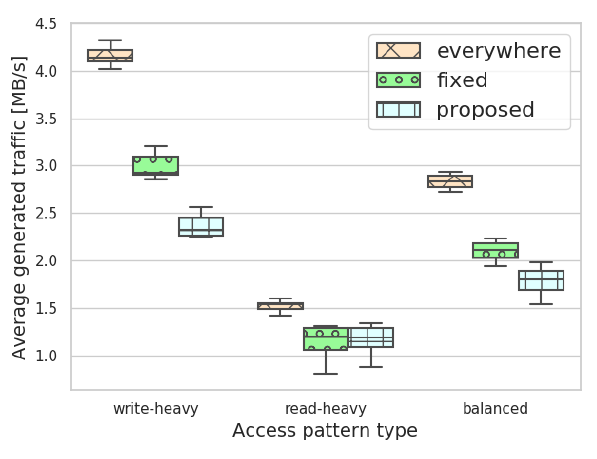
Figure 8. Average generated traffic by state accesses in the case of different state access patterns and replication